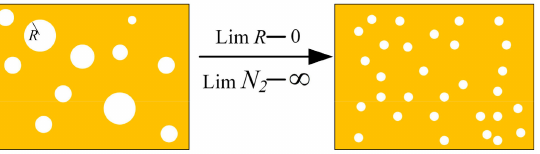
Figure 13. Schematic diagram of homogeneous model (R is radius of bubble; yellow area is liquid; bubbles are